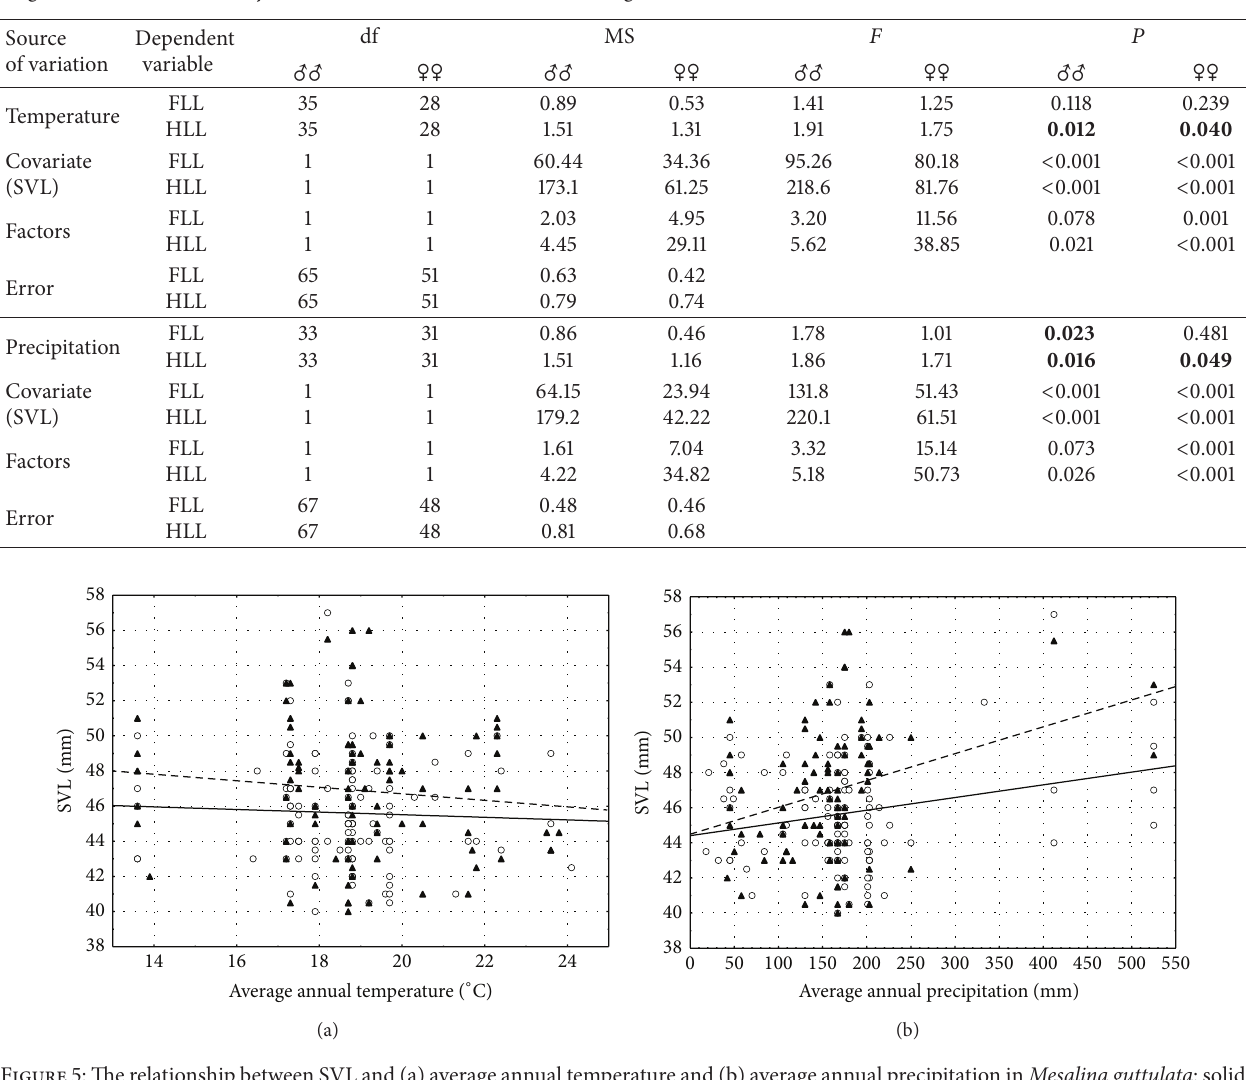
Table 6: Results of a MANCOVA examining the effect of temperature and precipitation on total fore limb length (FLL) and total hind limb length (HLL) in Acanthodactylus boskianus with SVL as a covariate. Significant effects are marked in bold letter.